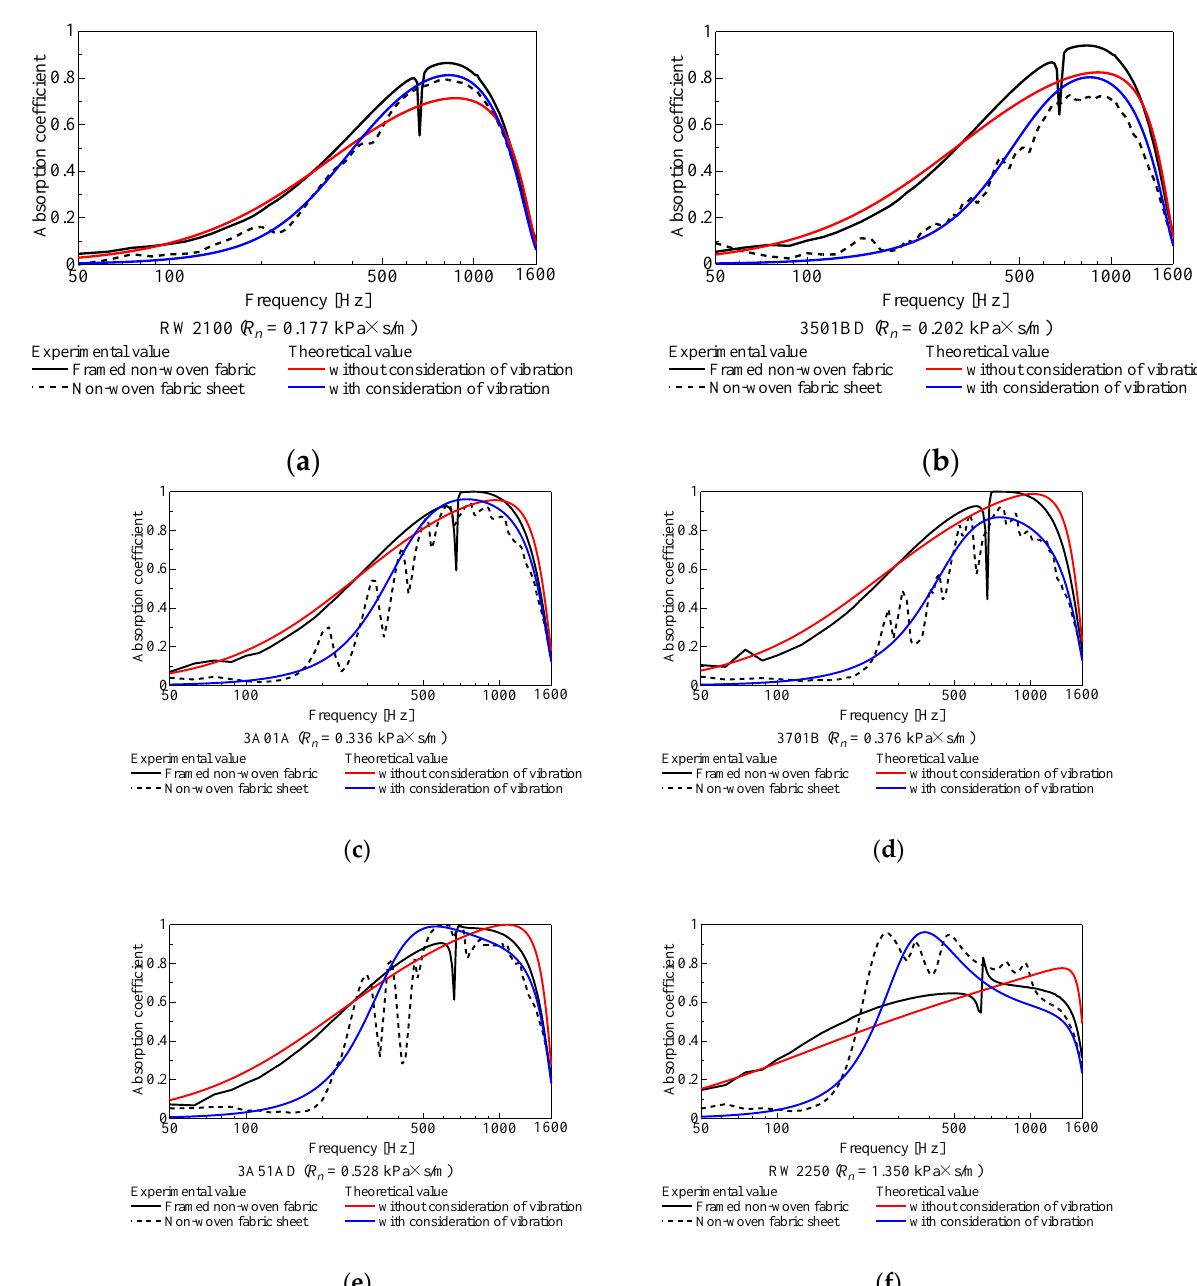
Figure 6. Comparison of experimental and theoretical values (length of back air space L = 100 mm): ( a ) RW2100; ( b ) 3501BD; ( c ) 3A01A; ( d ) 3701B; ( e ) 3A51AD; ( f ) RW2250.